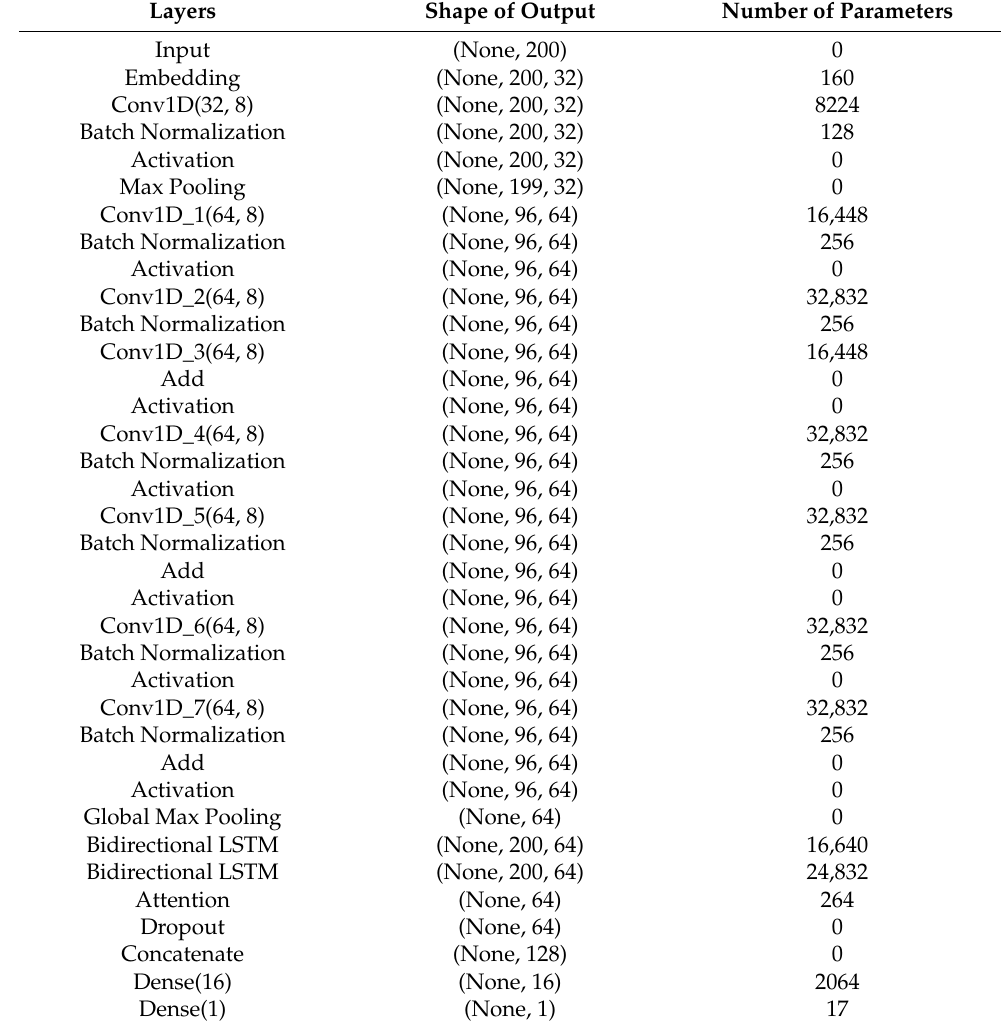
Table 1. The shapes of outputs and the numbers of parameters in the Enhancer-LSTMAtt. Layers Shape of